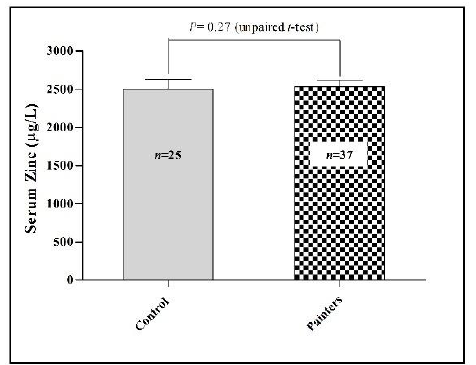
Figure (5): Serum zinc (Zn) levels of painting workers in Sulaimani city. n : number of subjects; P >0.05: non-significant difference compared with control group.